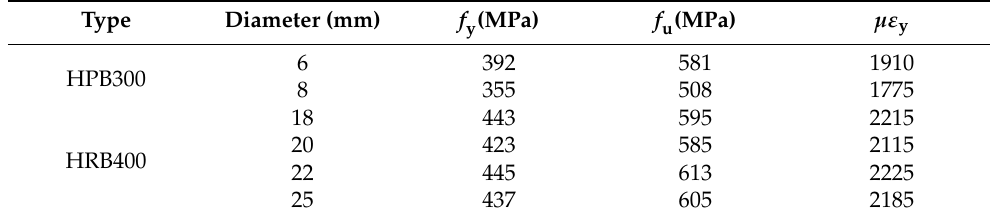
Table 4. Mechanical properties of steel reinforcement.